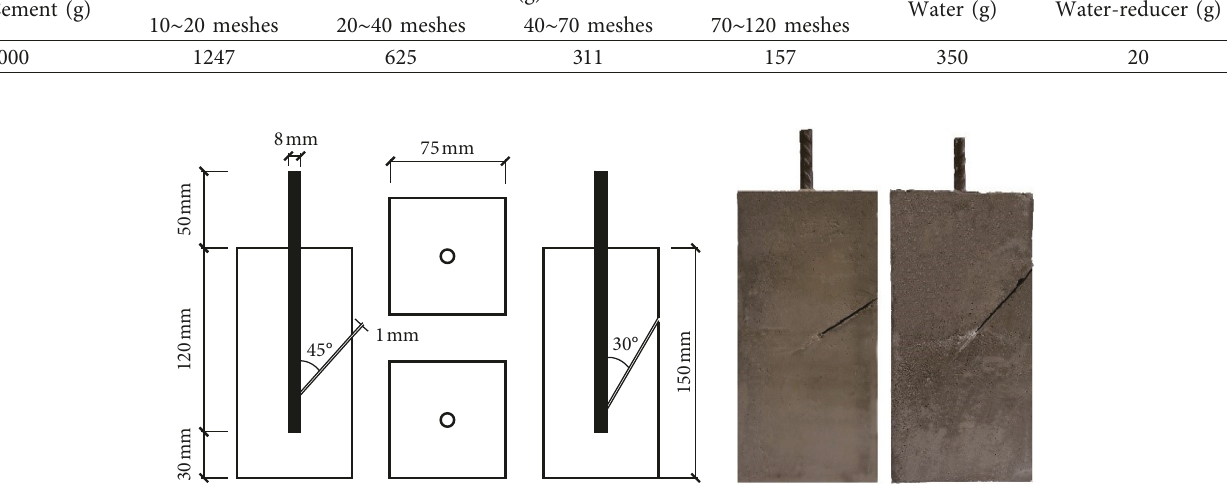
Figure 1: Complete specimen and its dimension drawing.